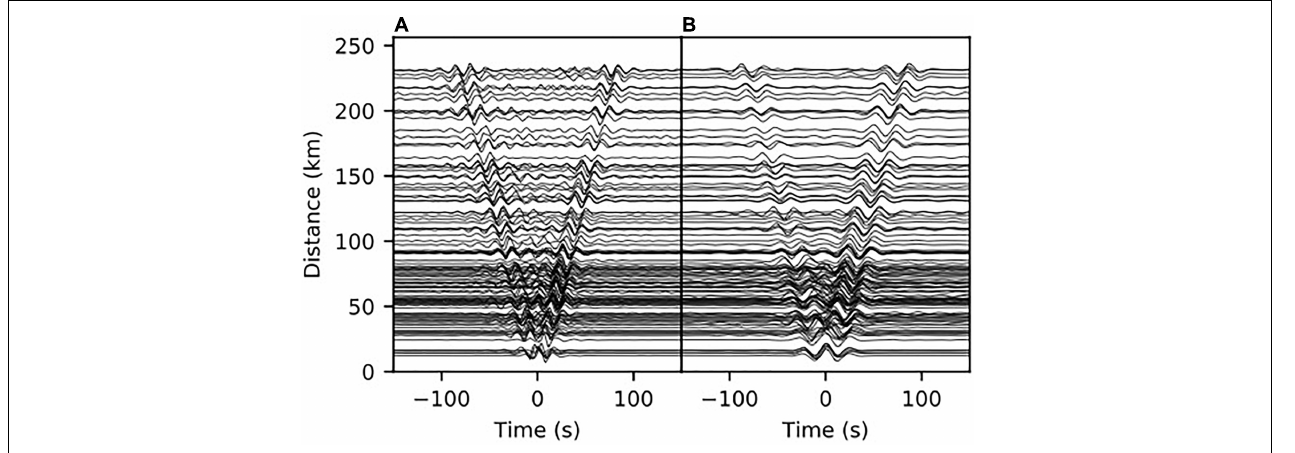
FIGURE 2 | Examples of the stacked correlograms between station D024 (the blue circle in Figure 1 ) and other contemporaneously operating stations. Correlograms filtered in the period range of 10–20 s (A) and 20–40 s (B)